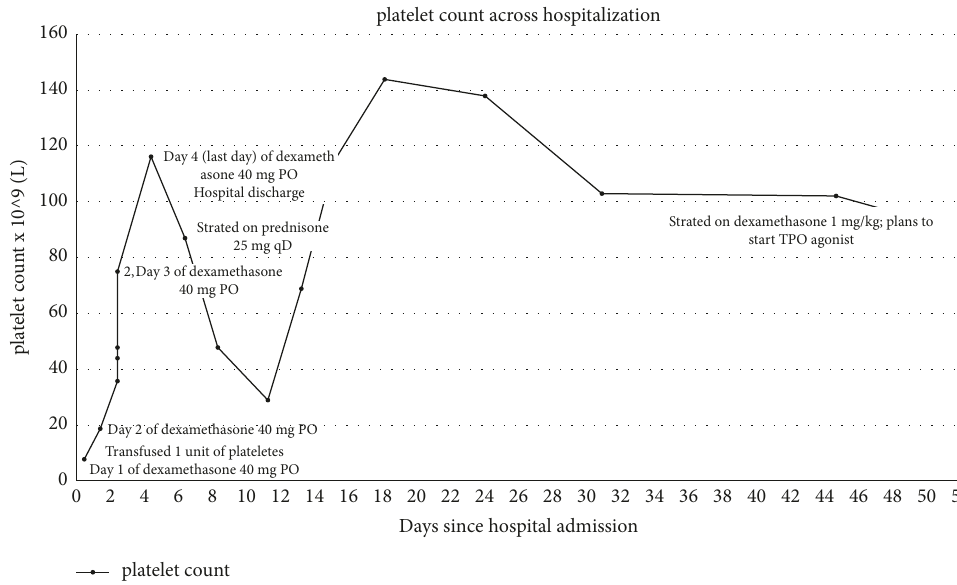
Figure 1: Platelet count across